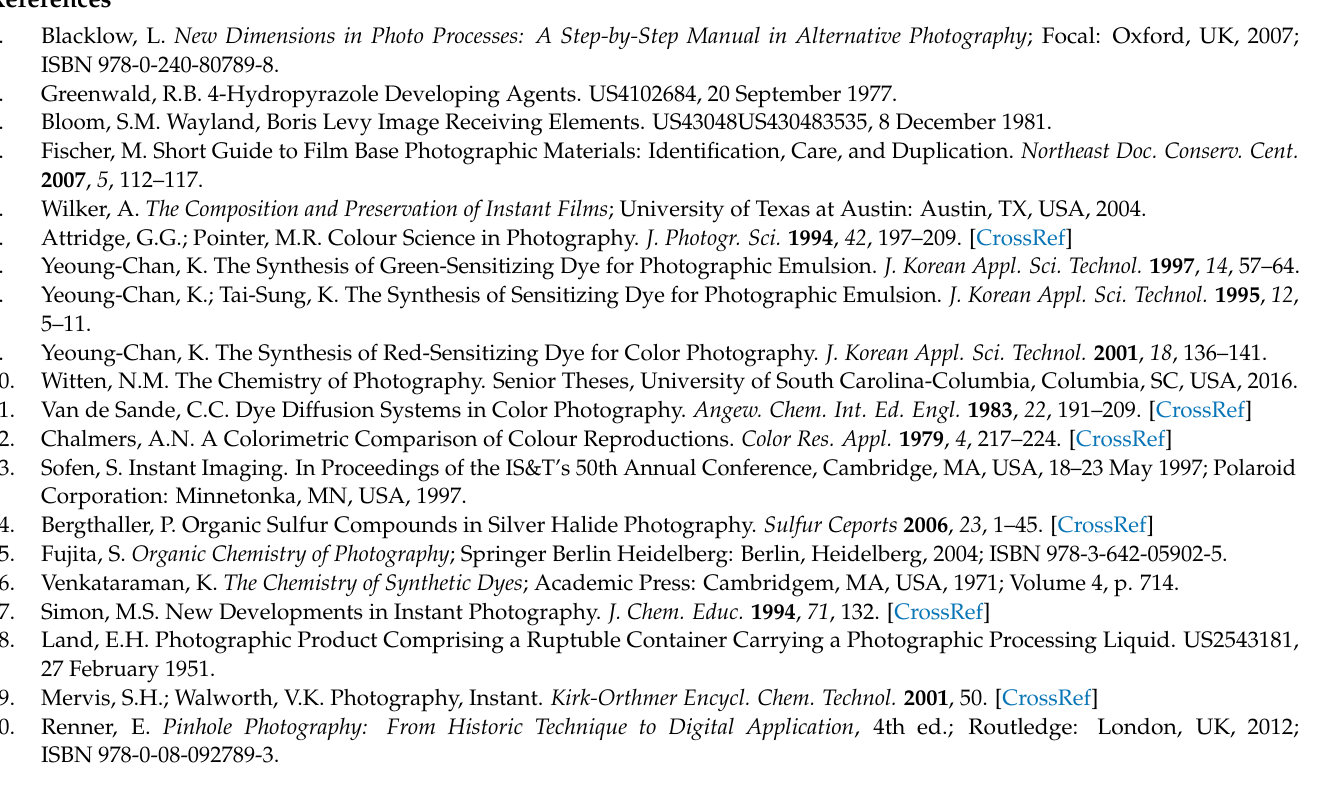
spectroscopy; Figure S4: Points of the mock-up sample analysed by FTIR spectroscopy; Figure S5: Points of Paolo Gioli’s artwork analysed by FTIR spectroscopy; Figure S6: A comparison of the absorption spectra of points T1 and T9; Figure S7: A comparison of FTIR spectra obtained for the mock-up (F1 point), paper, dry-gel and hydroxyethyl cellulose (solid and film from water dispersion); Figure S8: A comparison of FTIR spectra obtained for the mock-up (F1 point), paper, dry-gel and hydroxyethyl cellulose (solid and film from water dispersion) in the range 750–1800 cm − 1 ; Figure S9: A comparison of FTIR spectra obtained for the artwork (GF5 point), dry-gel and hydroxyethyl cellulose (solid and film from water dispersion); Figure S10: A comparison of FTIR spectra obtained for the artwork (GF5 point), dry-gel and hydroxyethyl cellulose (solid and film from water dispersion) in the range 750–1800 cm − 1